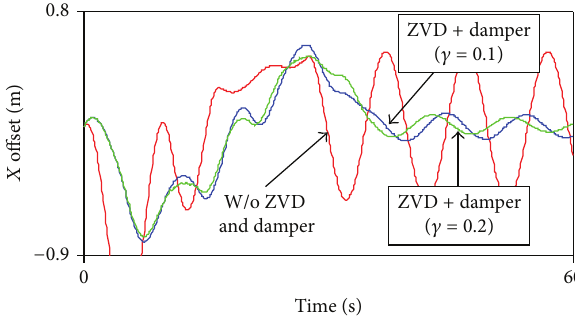
Figure 10: Effect of location parameter on the spreader 𝑋 -offset.